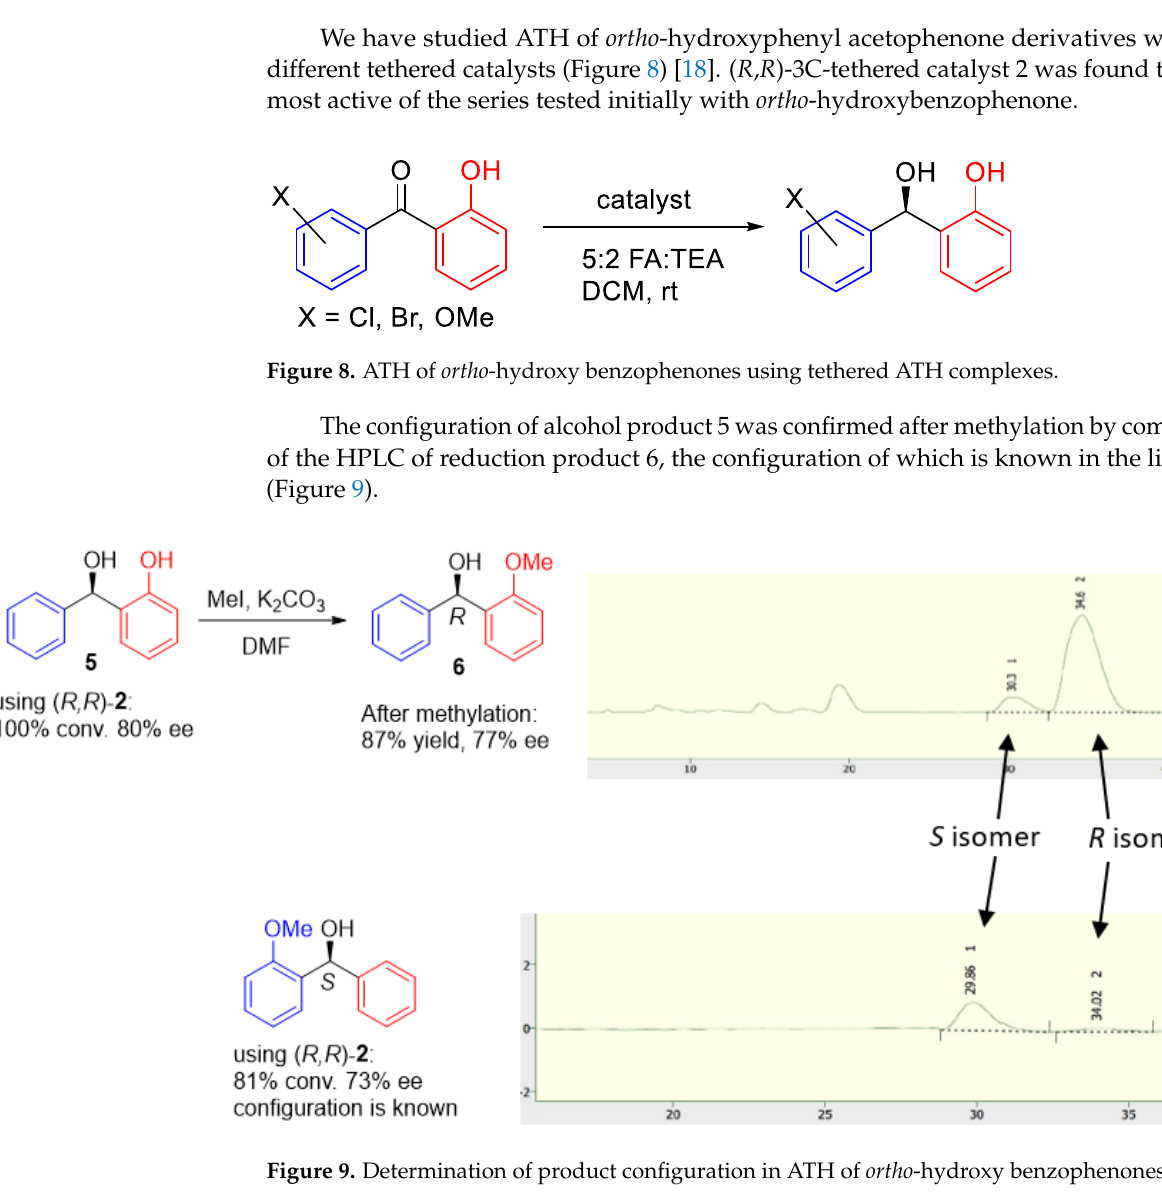
Figure 7. Examples of ATH of benzophenone derivatives and heterocyclic ketones using Noyori – Ikariya catalysts (The red part favours positioning adjacent to η 6 -arene of catalyst, while the blue part favours positioning distal to η 6 -arene of catalyst).